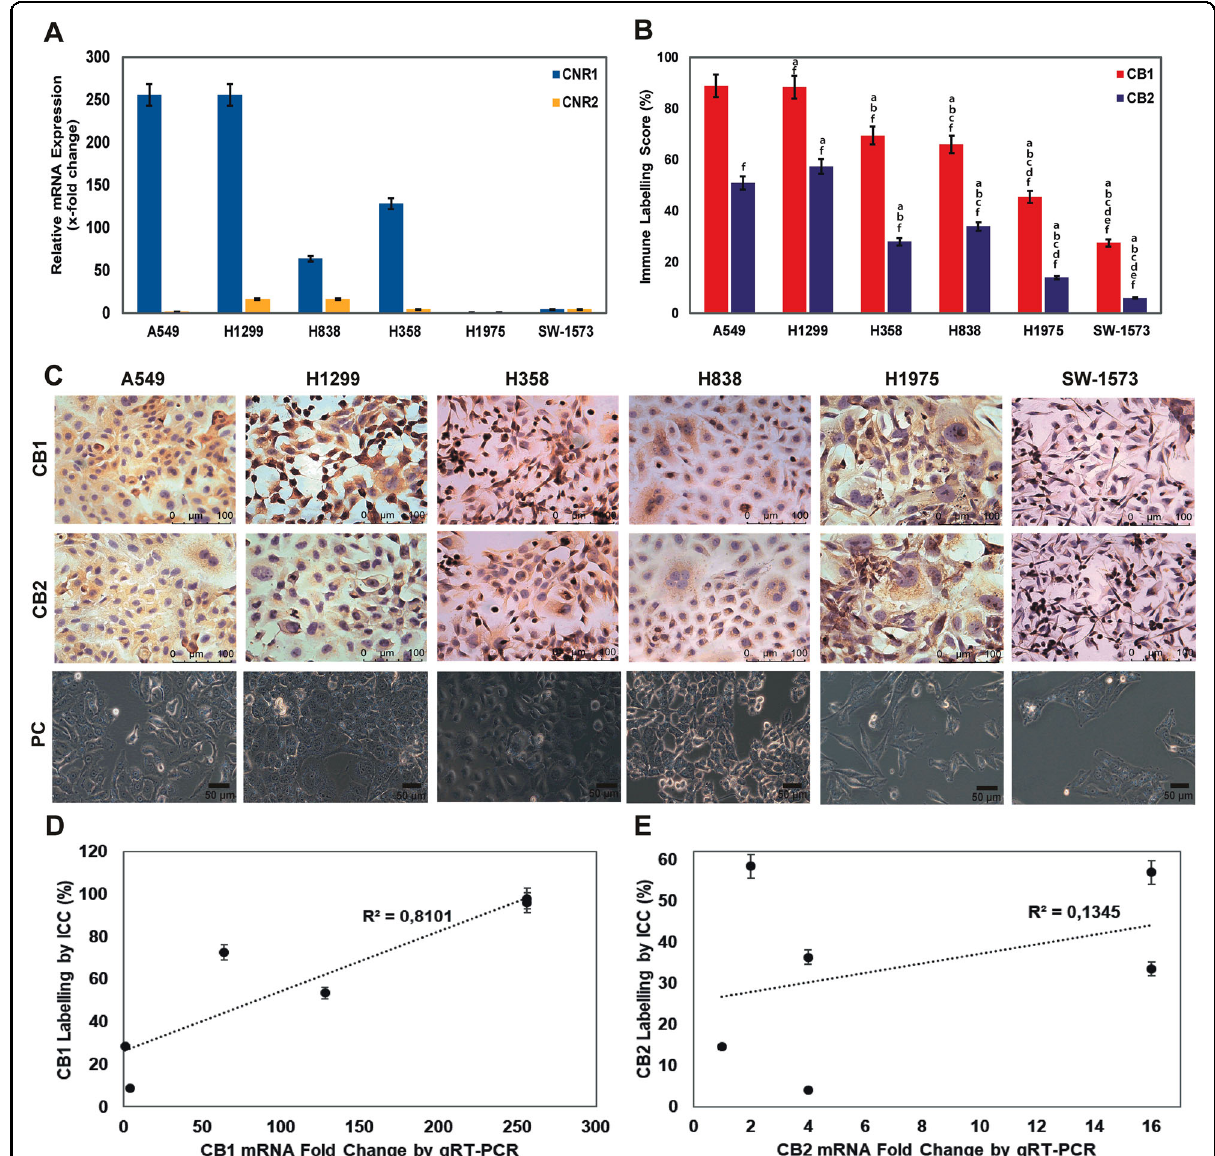
Fig. 1 NSCLC cell lines express CB1R. a qRT-PCR analysis for relative mRNA fold change values of CB1R and CB2R genes relative to β -actin. The results are represented with 5% error. b Bar graph presenting the percentage of CB1 and CB2 indirect immune peroxidase-labeled cells with mean ± SEM, ( n = 25), a, b, c, d, and e denote p < 0.05 comparing to A549, H1299, H358, H838, and H1975 cells respectively and f refers to p < 0.05 comparing CB2 to CB1 in each cell line, one-way analysis of variance (ANOVA). c Micrographs presenting CB1 and CB2 indirect immune peroxidase-labeled (scale bar, 100 µm) and phase-contrast (PC, scale bar, 50 µm) view of NSCLC A549, H1299, H358, H838, H1975, and SW-1573 cell lines, ×400. d , e Correlation graph of CB1 ( d ) and CB2 ( e ) receptor immune labeling and mRNA expression levels (correlation coef fi cient: R 2 , p = 0.024, and p = 0.824 respectively with Spearman ’ s